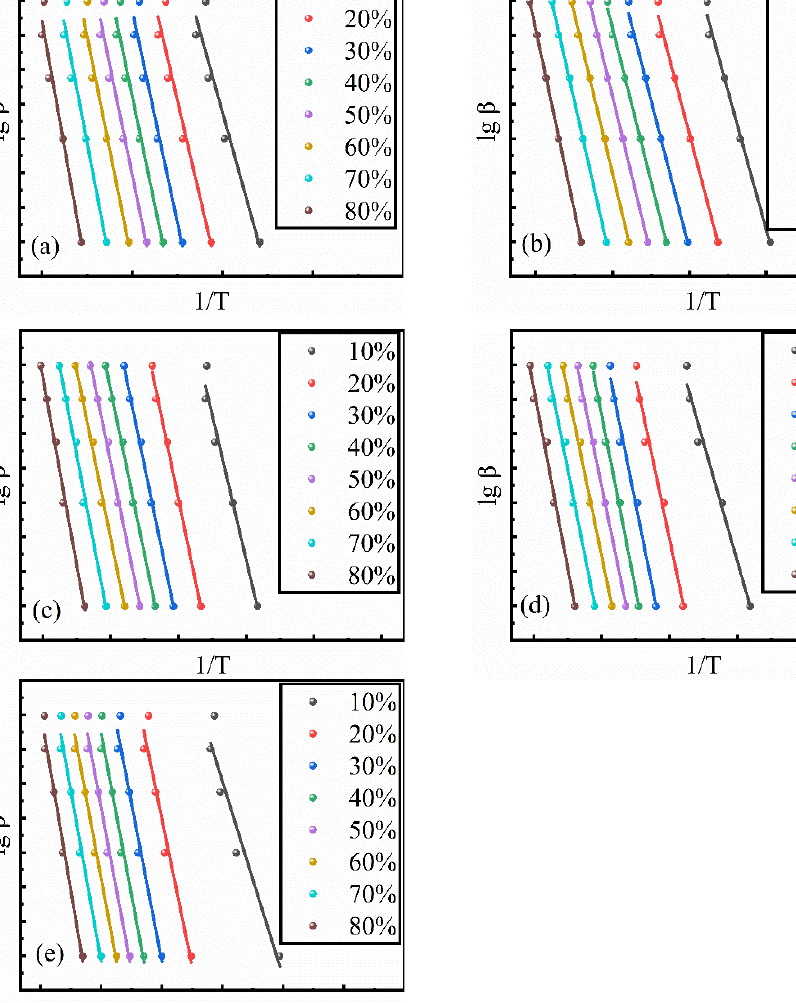
Figure 7. Relationship between lg β and 1/Tp in thermal degradation. ( a ) EP-(P-M 0%), ( b ) EP-(P-M